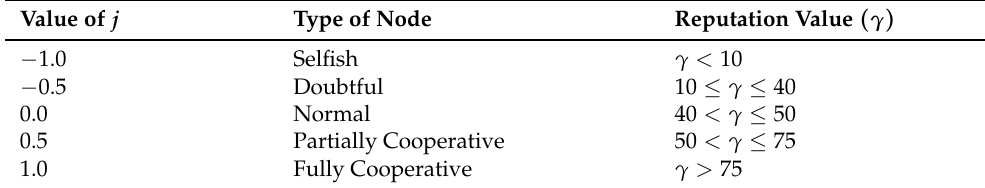
Figure 2. Overall Structure of Proposed Scheme. Table 3. Value of constant j according to classification of node in